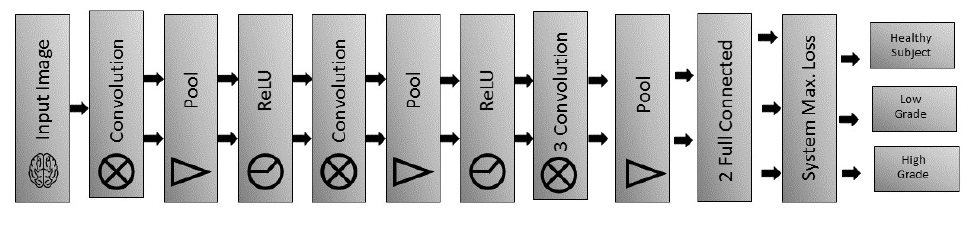
Figure 2. Layer structure of the proposed